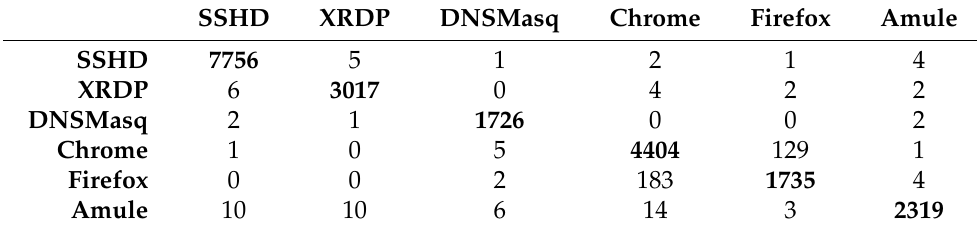
Table 11. C45: confusion matrix (UPC,